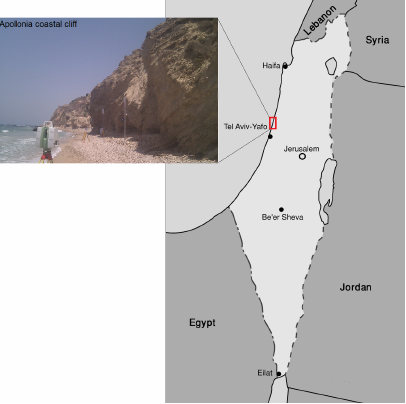
Figure 3: Study site: the Apollonia cliff along Israel’s